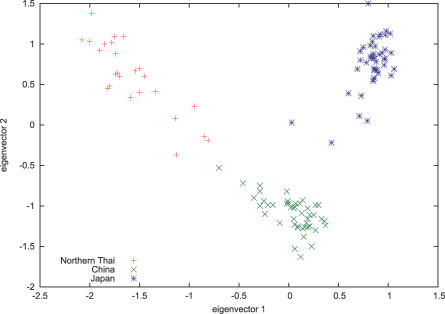
Three East Asian PopulationsPlots of the first two eigenvectors for a population from Thailand and Chinese and Japanese populations from the International Haplotype Map [32]. The Japanese population is clearly distinguished (though not by either eigenvector separately). The large dispersal of the Thai population, along a line where the Chinese are at an extreme, suggests some gene flow of a Chinese-related population into Thailand. Note the similarity to the simulated data of Figure 8.